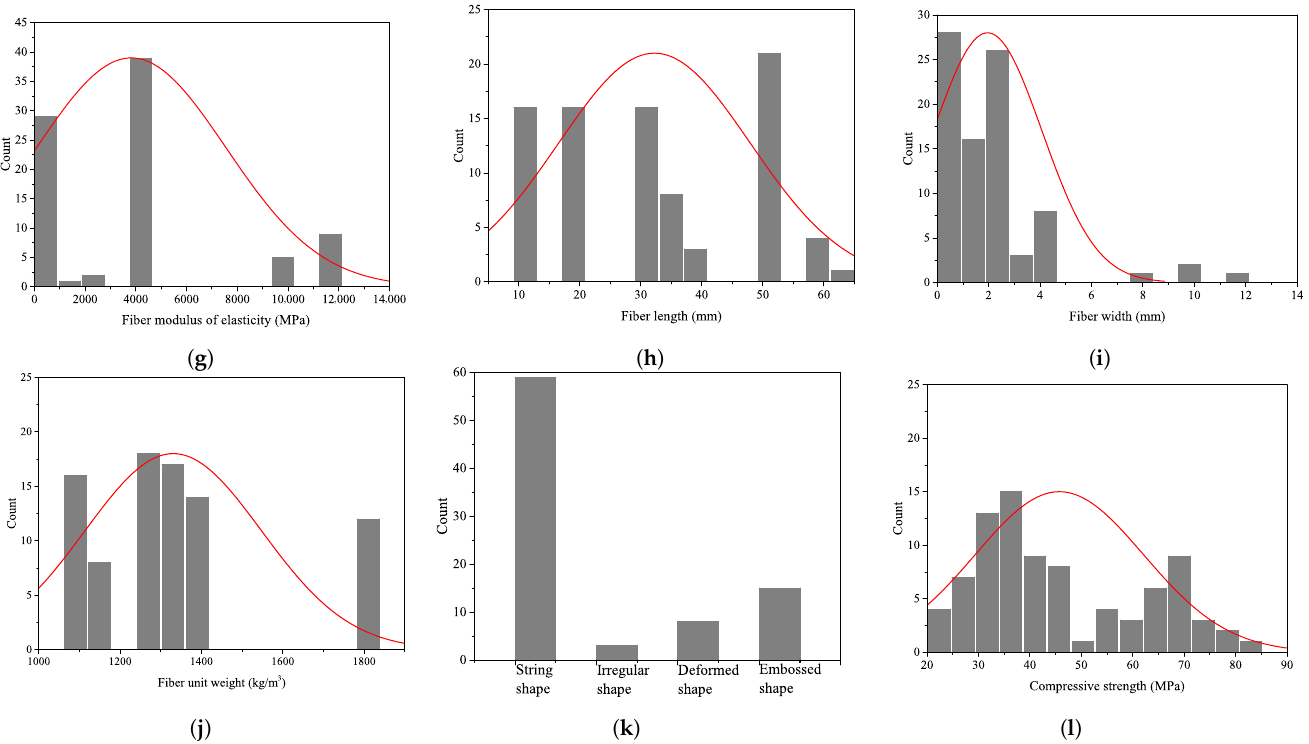
Figure 2. The histograms for features of the network ( a ) Binder (kg/m 3 ), ( b ) Water (kg/m 3 ), ( c ) Coarse aggregate (kg/m 3 ), ( d ) Fine aggregate (kg/m 3 ), ( e ) PET fiber (kg/m 3 ), ( f ) Fiber tensile strength (MPa), ( g ) Fiber modulus of elasticity (MPa), ( h ) Fiber length (mm), ( i ) Fiber width (mm), ( j ) Fiber unit weight (kg/m 3 ), ( k ) Fiber shape, ( l ) Compressive strength